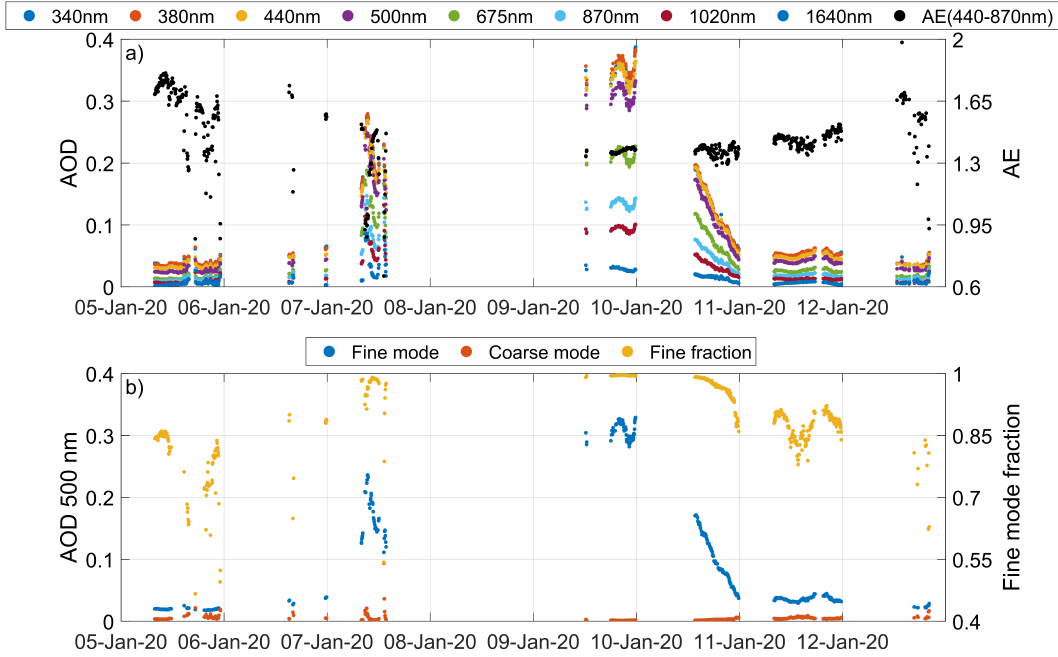
Figure 2. ( a ) Aerosol optical depth (AOD) for different wavelengths and Ångström exponent (AE) at Marambio on 5–12th January 2020. ( b ) Fine and coarse mode aerosol optical depth at 500 nm and the fine mode fraction at Marambio on 5–12th January